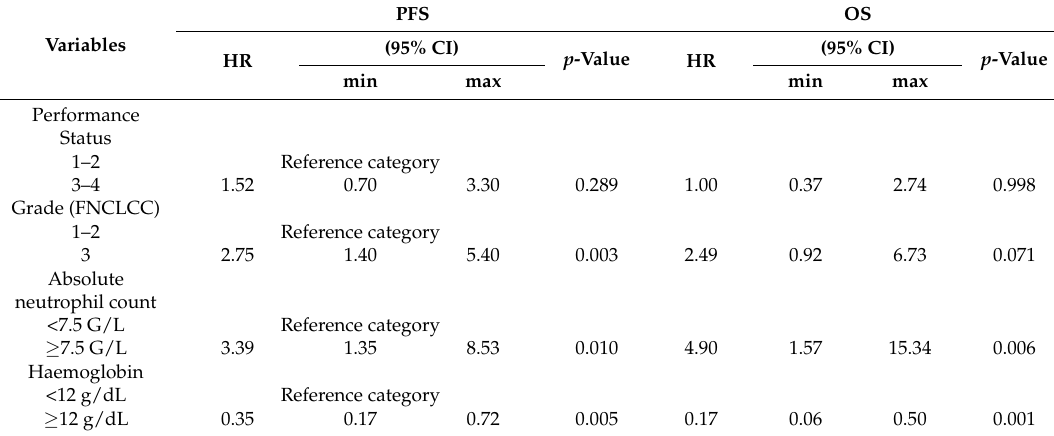
Table 3. Multivariate analysis of factors associated with progression-free survival (PFS) and overall survival